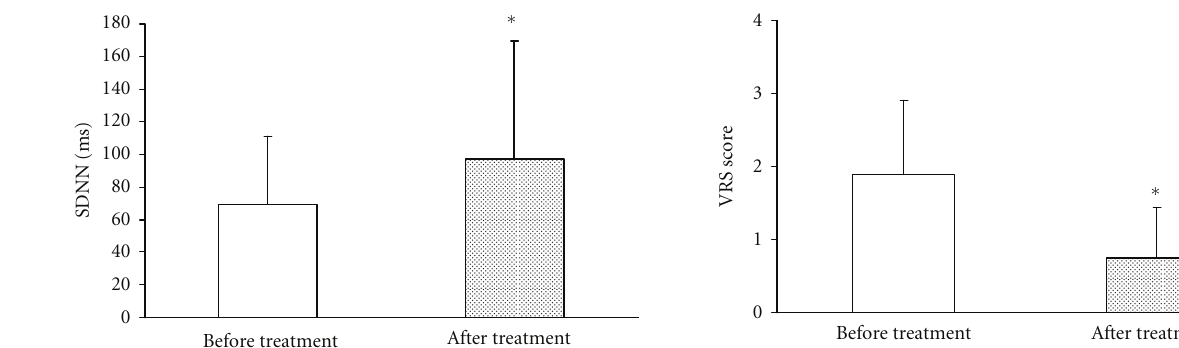
Figure 5: The mean SDNN values before and after treatment. Expression values are the mean and standard deviation, and Wilcoxon Signed-Rank Test was used to test the statistical di ff erence between groups. Asterisk means that this group has statistical di ff erence with control group ( P < 0 . 05).